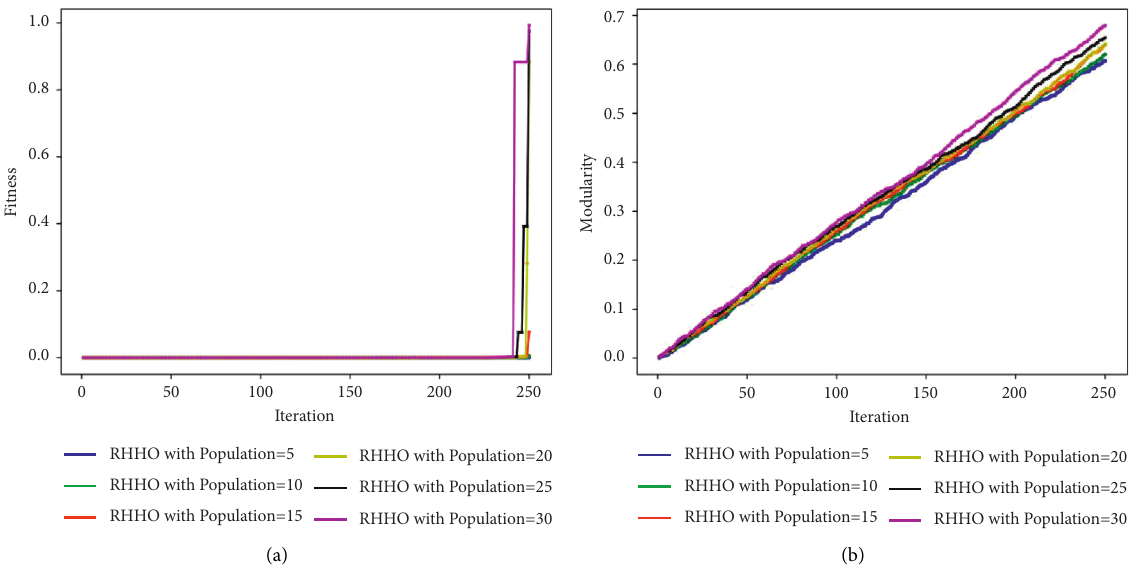
Figure 6: Performance analysis of proposed RHHO using Movie Lens 100 K considering (a) fitness and (b)